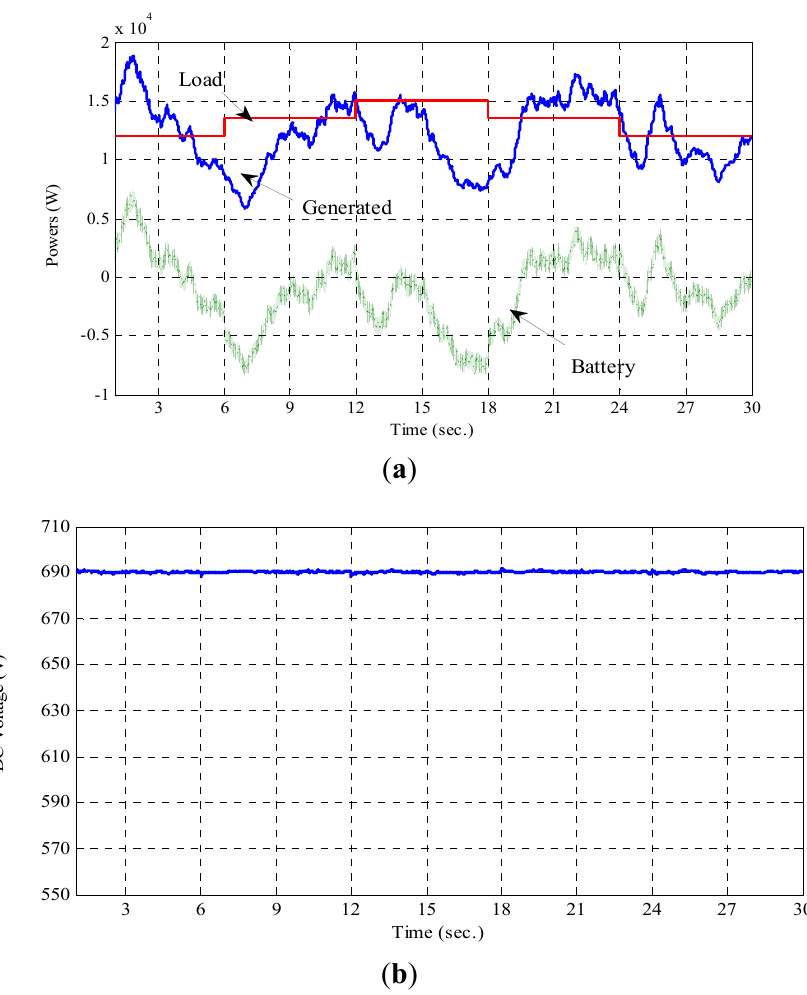
Figure 15. The performance of DC-DC bidirectional converter controller. ( a ) Generated, load, and batteries bank powers; ( b ) DC-link